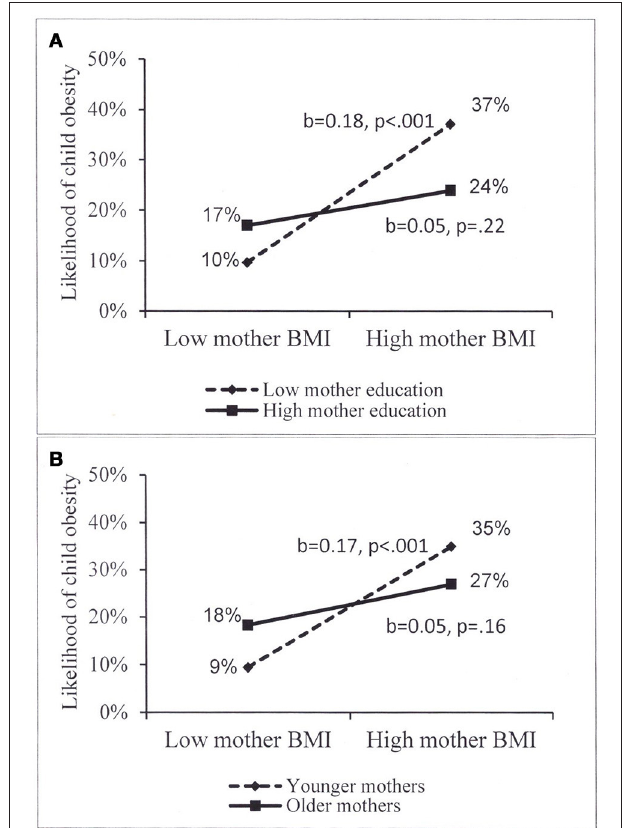
FIGURE 1 | (A,B) Moderation of the association of mother BMI with child overweight/obesity among Jewish children, by (A) mother eduction, high eduction = more than 15 years of eduction; (B) mother age, older age = above 39.9 years of